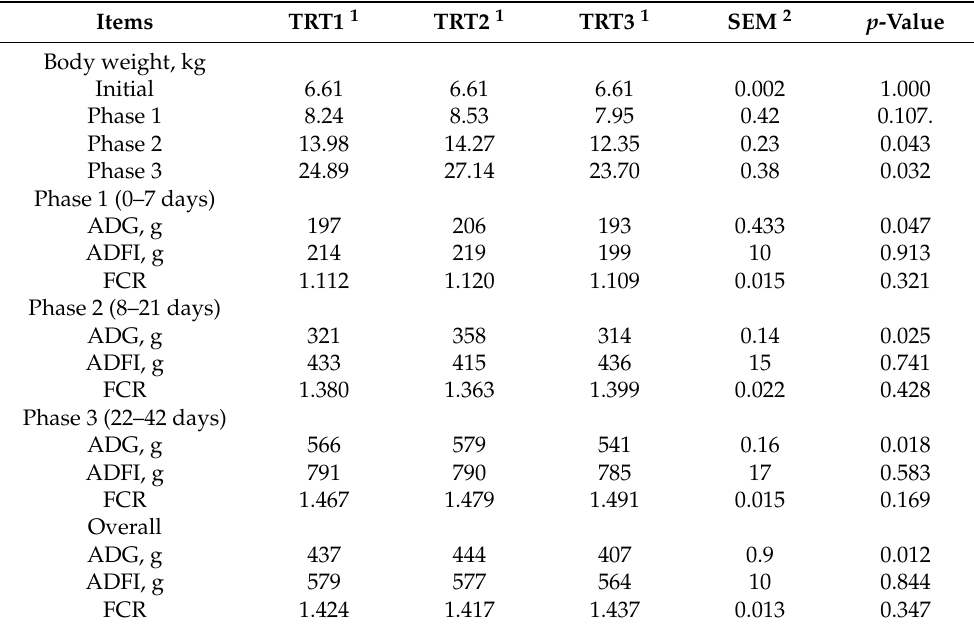
Table 2. Effect of blood plasma and yeast supplementation on the growth performance of weaning pigs 1 .